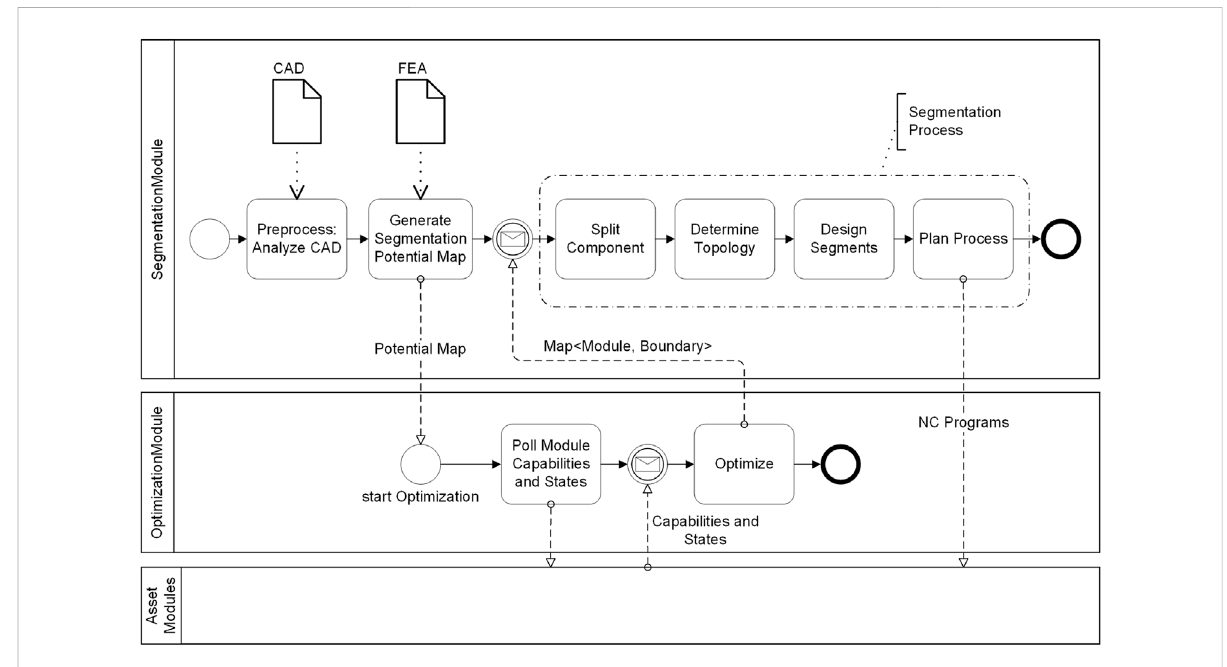
FIGURE 2 Work fl ow of the segmentation